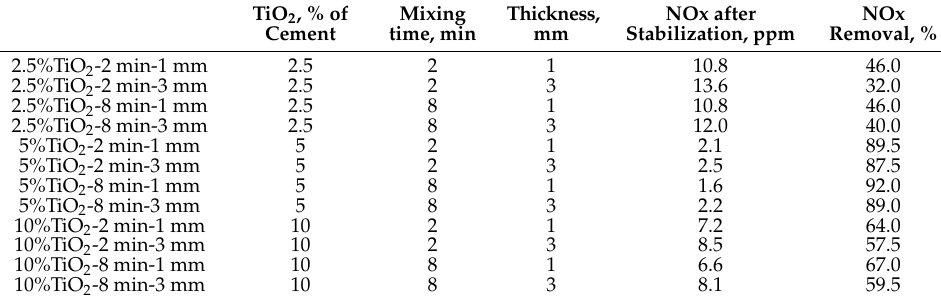
Table 3. NOx properties for tested cement